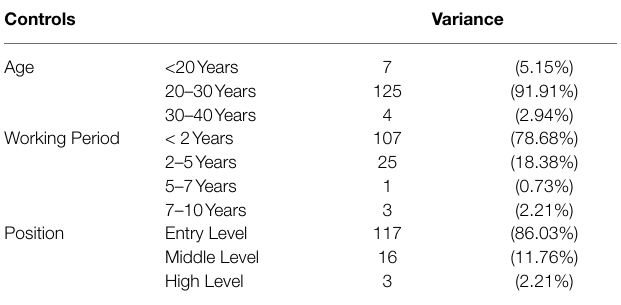
TABLE 1 | Demographic information. TABLE 2 |